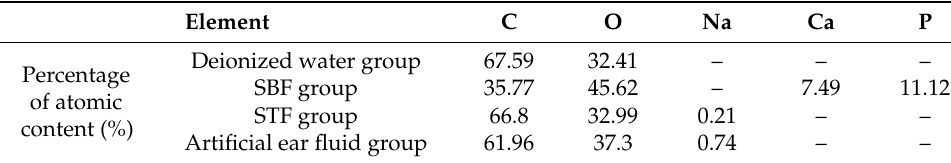
Table 3. The data of element content by